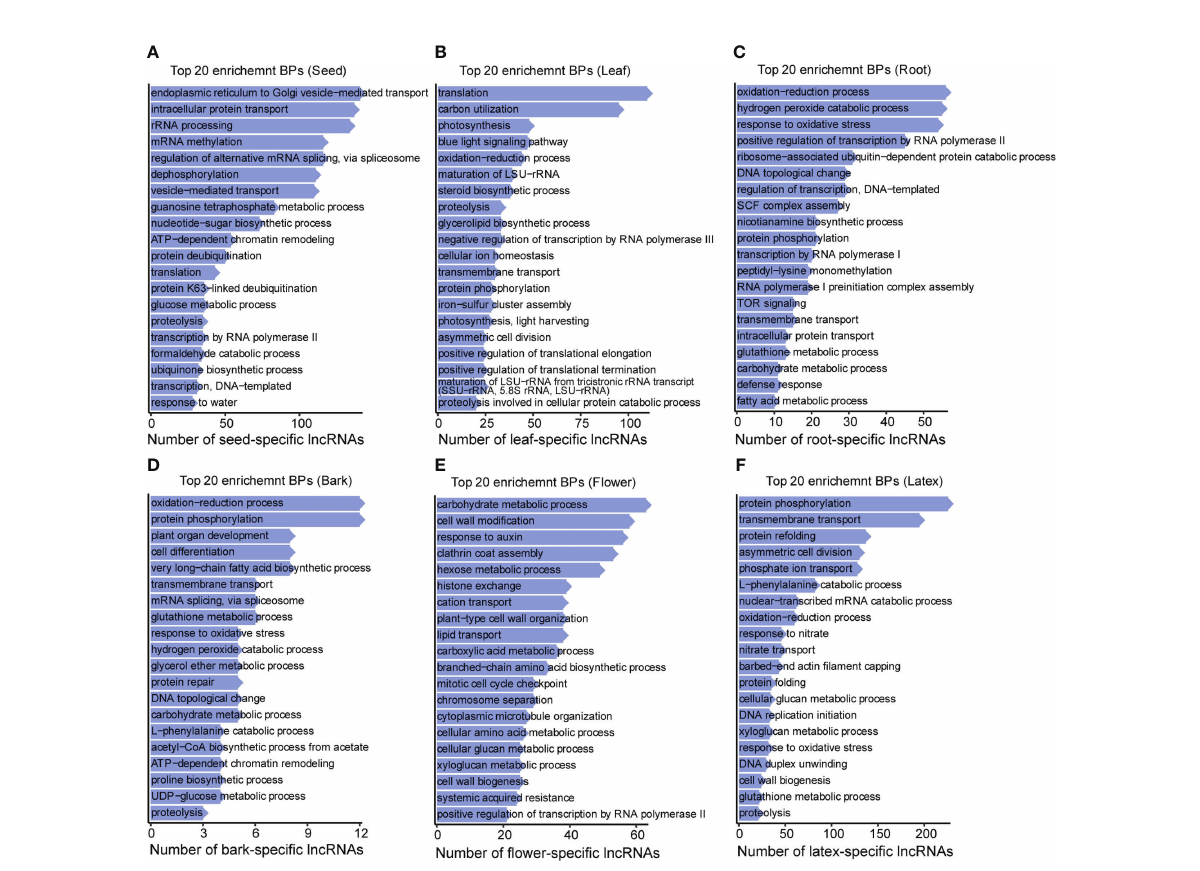
FIGURE 5 Top 20 enrichment BPs for the tissue-speci fi c lncRNAs. Top 20 enrichment biological processes (BPs) for the tissue-speci fi c lncRNAs in (A) seed, (B) leaf, (C) root, (D) bark, (E) fl ower, and (F) latex, separately. Y axis is the term of biological processes, while X axis represents the number of tissue-speci fi c lncRNAs.